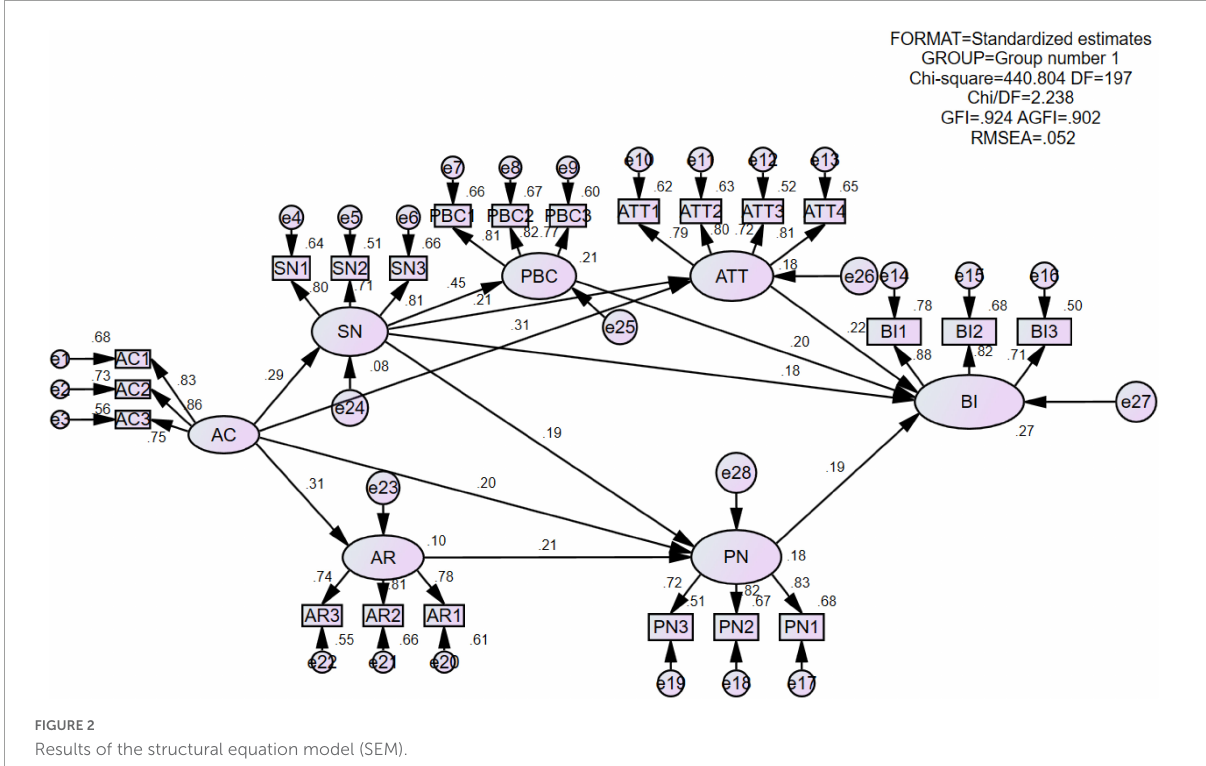
FIGURE2 Results of the structural equation model (SEM).